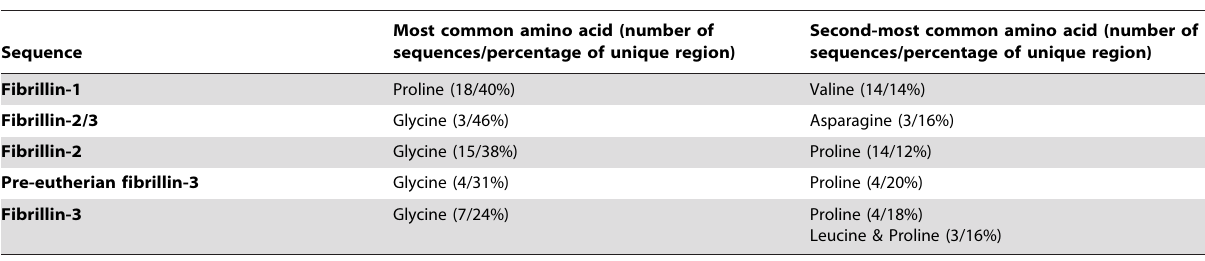
Table 2. Amino acid composition of the unique